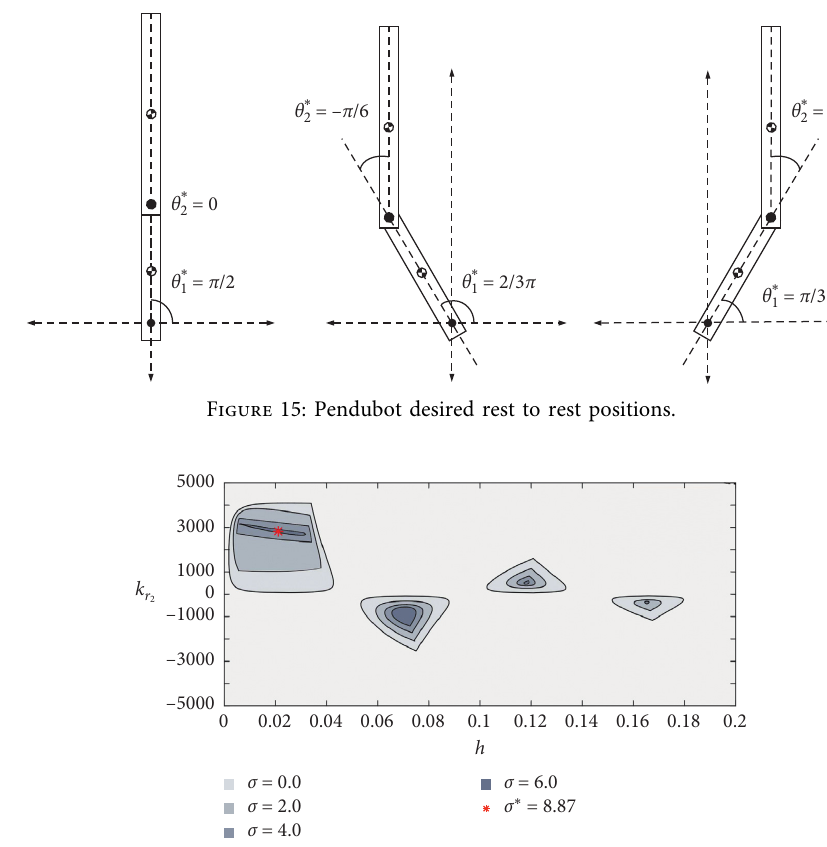
Figure 16: σ -stability boundaries.